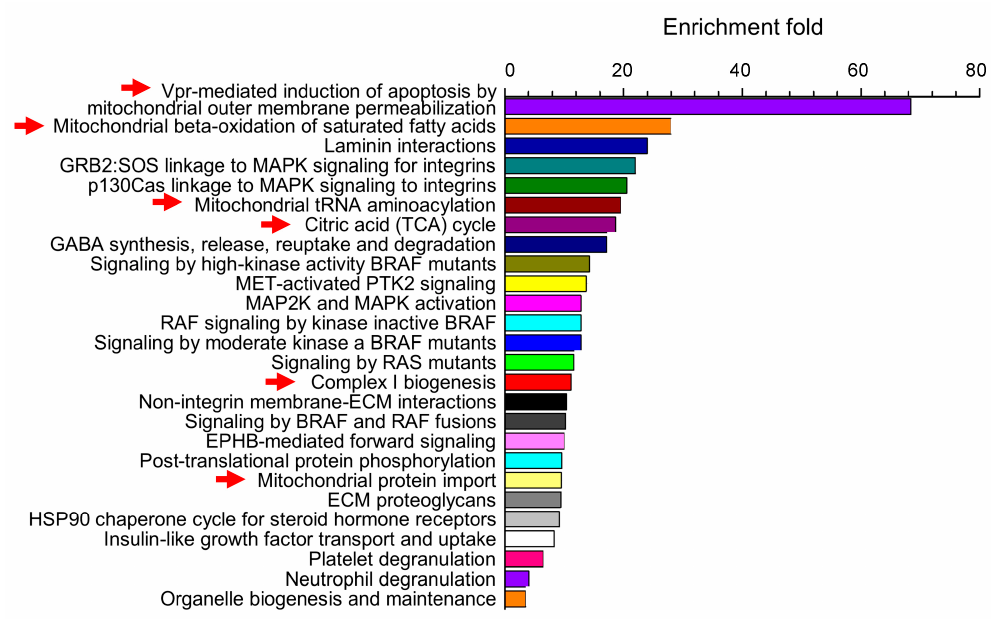
Figure 3. Statistical enrichment analysis points to the statistically significant overrepresentation of mitochondria-related pathways within the set of baboon fetal cerebral artery proteome that is sensitive to prenatal alcohol exposure. Enrichment fold refers to the increase in appearance of proteins within each pathway when compared to the relative distribution of these proteins within Homo sapience proteome. Thus, proteins on this plot do not reflect frequency of appearance in the overall proteome but rather a group of proteins that is selectively targeted by prenatal alcohol exposure. With modifications from [27].